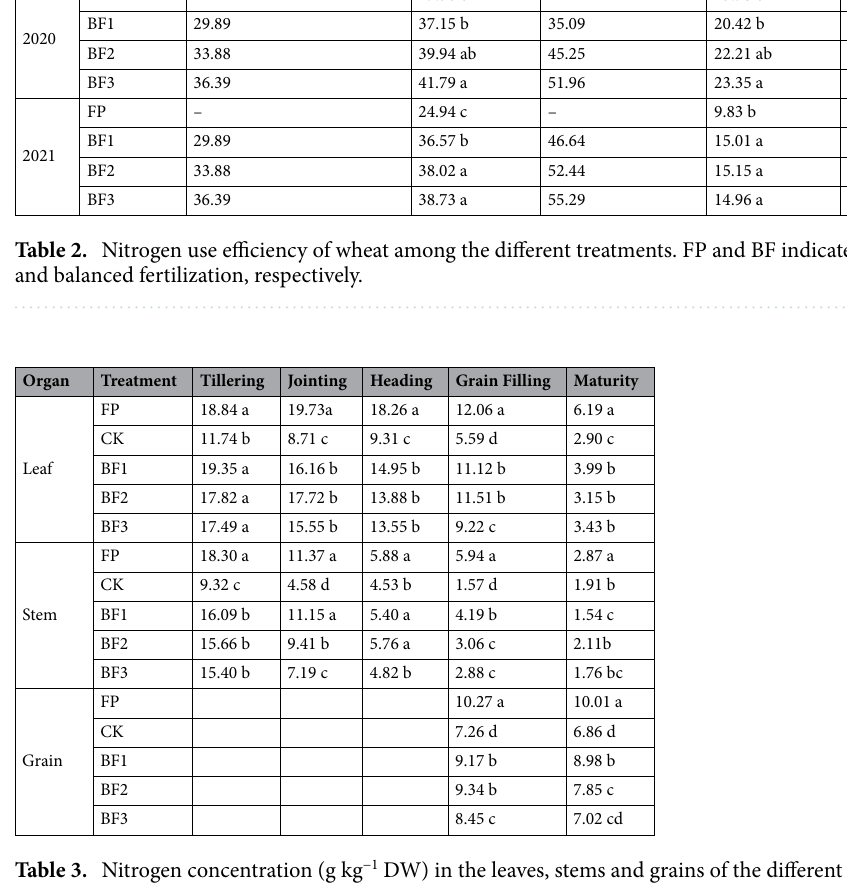
Table 3. Nitrogen concentration (g kg −1 DW) in the leaves, stems and grains of the different treatments at different growth stages in 2019. FP, CK and BF indicate farmer practice, control and balanced fertilization, respectively. Values within a column with different letters are significant at the P = 0.05 level.